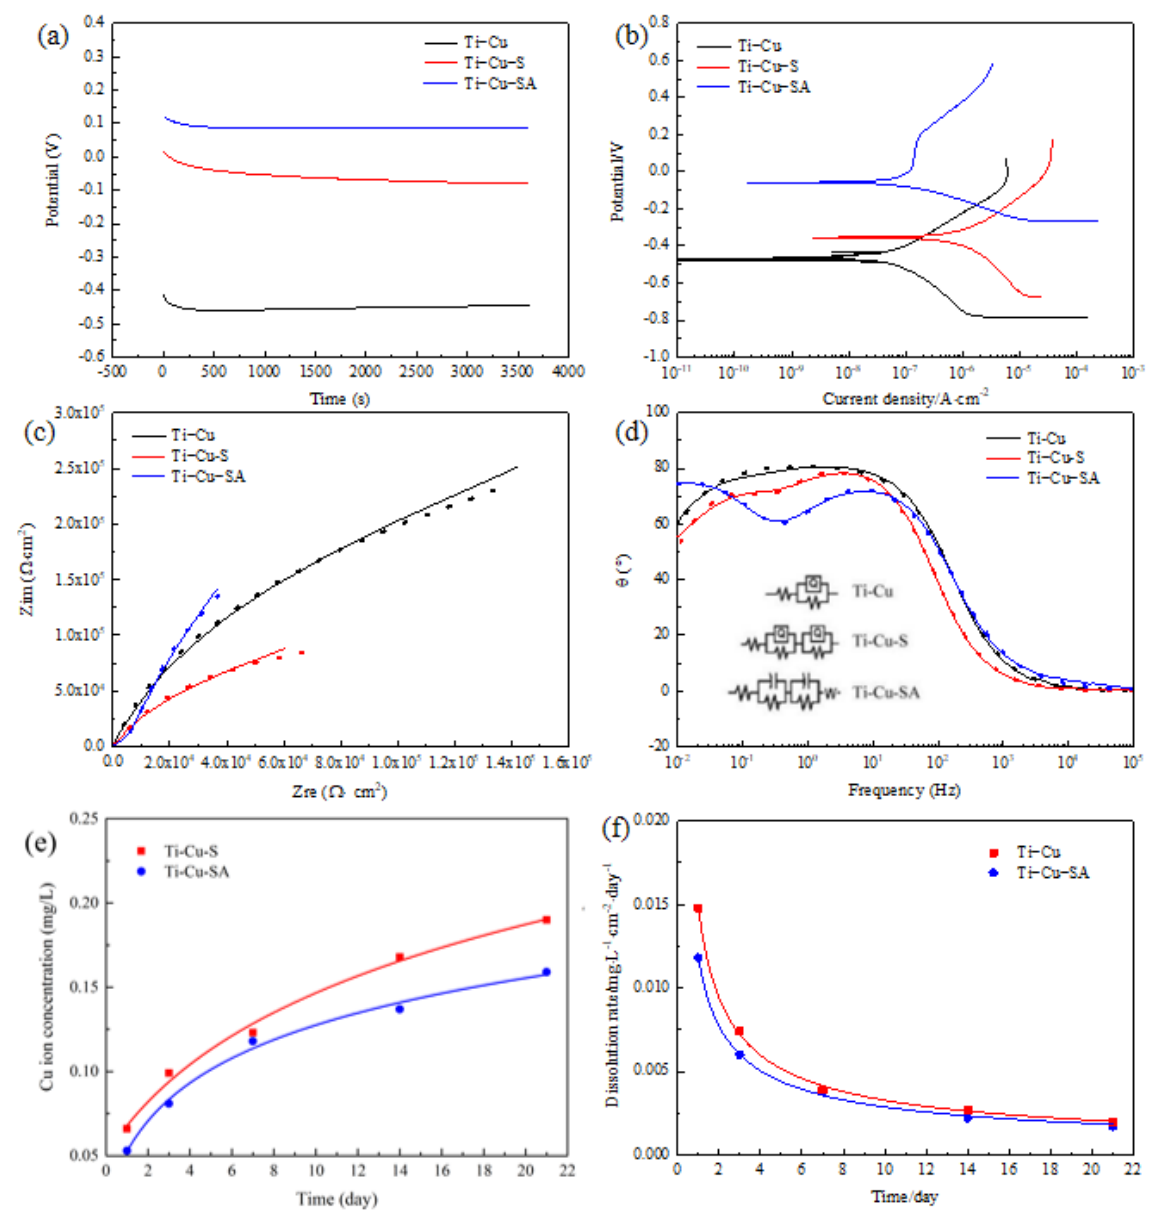
Figure 4. Electrochemical test results and Cu ion release of Ti-Cu samples: ( a ) OCP; ( b ) Tafel; ( c ) Nyquist; ( d ) Bode; ( e ) Cu ion accumulated concentration; and ( f ) Cu ion release rate.